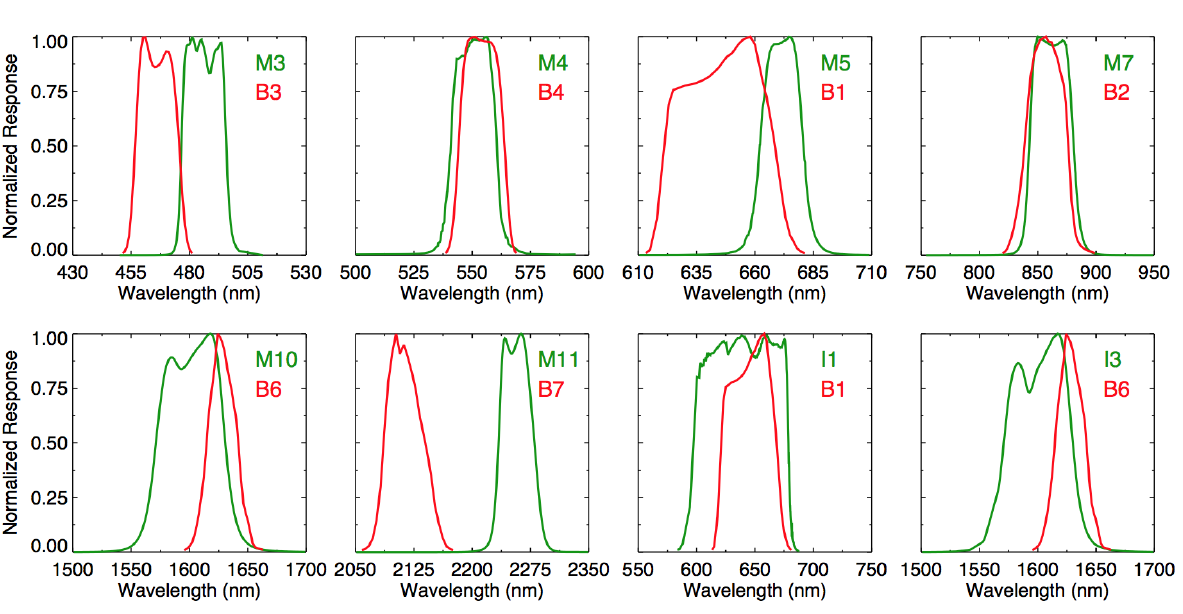
Figure 1. Comparison of the spectral response functions (SRFs) of the matching spectral bands of the MODIS (in red) and VIIRS (in green) instruments. Band numbers are posted in the upper left